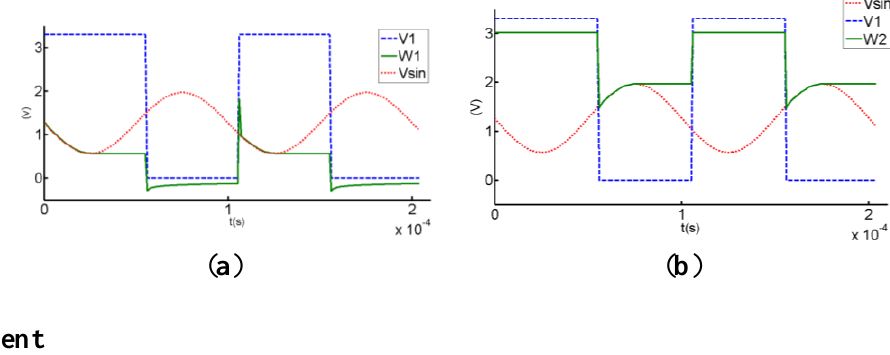
Figure 9. ( a ) Simulation waveform of tracking circuit in the trough tracking state. ( b ) Simulation waveform of tracking circuit in the crest tracking state.